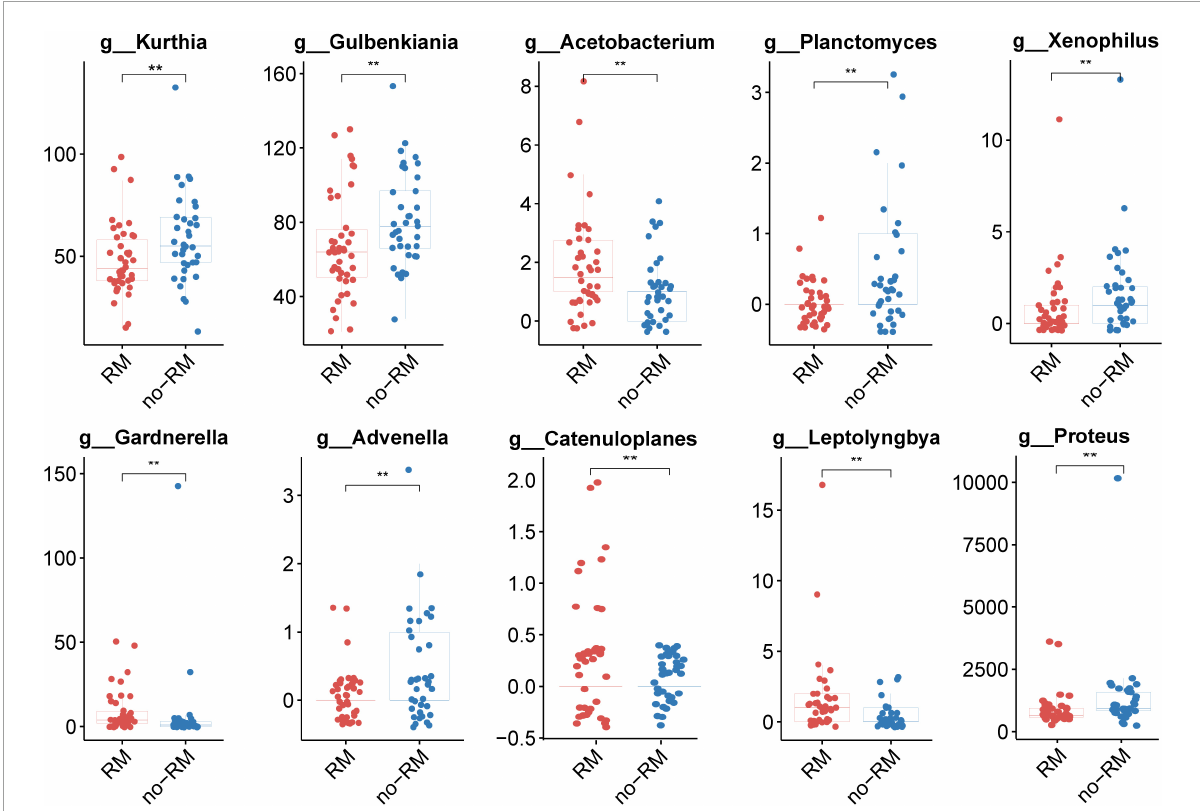
FIGURE3 Ten potential biomarkers capable of distinguishing between RM and no-RM. Wilcoxon test was used to detect variation between different groups based on the relative abundance of tissue microbes, When the p -value was less than 0.01, 10 potential genus level microbial markers were identified; the boxplot was used to show the differences between the two groups; RM, recurrence or metastasis; no-RM, without recurrence and